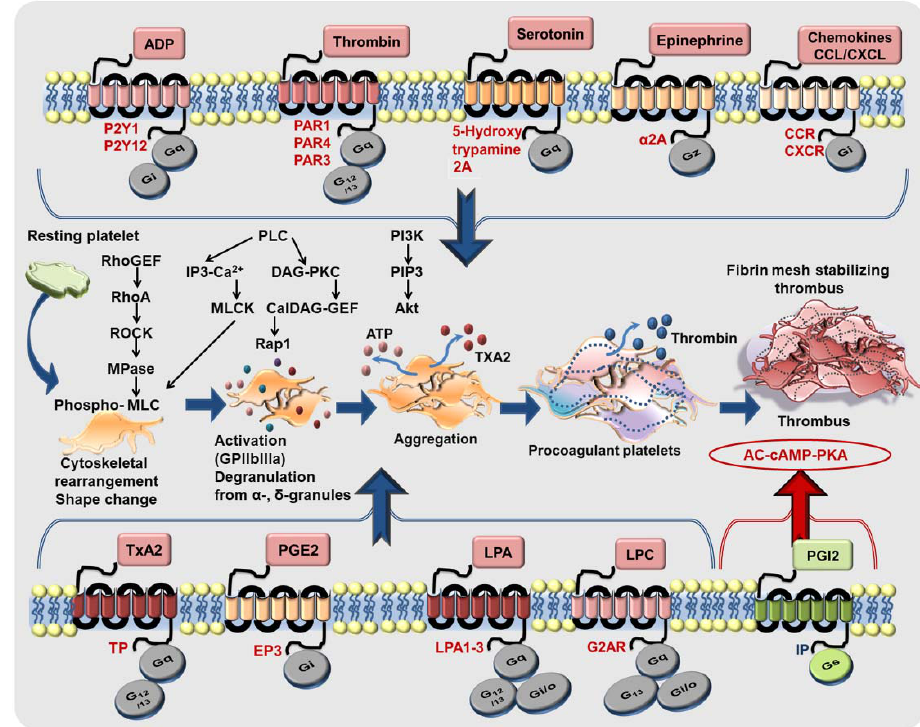
Figure 5. GPCRs driving platelet response to activating stimuli. Platelet ‐ activating pathophysiological stimuli (nucleotides, protease, peptides, lipid agonists, amines, chemokines) engage several GPCRs coupled with diverse G ‐ proteins (G q , G 12/13 , G i, G z ) to orchestrate platelet shape change, activation, degranulation, aggregation, procoagulant function leading to thrombus formation. Lipid agonists thromboxane A 2 (TxA 2 ) and prostaglandin E 2 (PGE 2 ), lysophatidylcholine (LPC) and lysophosphatidic acid (LPA) also propagate platelet activation through GPCRs. Platelet activation downstream of different GPCRs is both extensive and intricate. However, they engage some common mediators like Rho ‐ guanine nucleotide exchange factor (RhoGEF), calcium and diacyl glycerol ‐ regulated guanine nucleotide exchange factor (CalDAG ‐ GEF), myosin phosphatase (MPase), and signature signaling events involving phospholipase C (LPC) activation, generation of lipid signaling intermediates inositol 3 phosphate (IP3), diacylglycerol (DAG), phosphatidylinositol 3,4,5, trisphosphate (PIP3), intraplatelet calcium mobilization, myosin light chain (MLC) phosphorylation, activation of protein kinases, e.g., Rho ‐ associated kinase (ROCK), myosin light chain kinase (MLCK), protein kinase C (PKC), phosphatidylinositol 3 kinase (PI3K), Akt. Platelet inhibitory prosglandin I 2 (PGI 2 ) also exerts its action through G s coupled IP ‐ receptor and triggers the platelet inhibitory signaling cascade involving adenylyl cyclase (AC), cyclic adenosine monophosphate (cAMP) and protein kinase A (PKA).